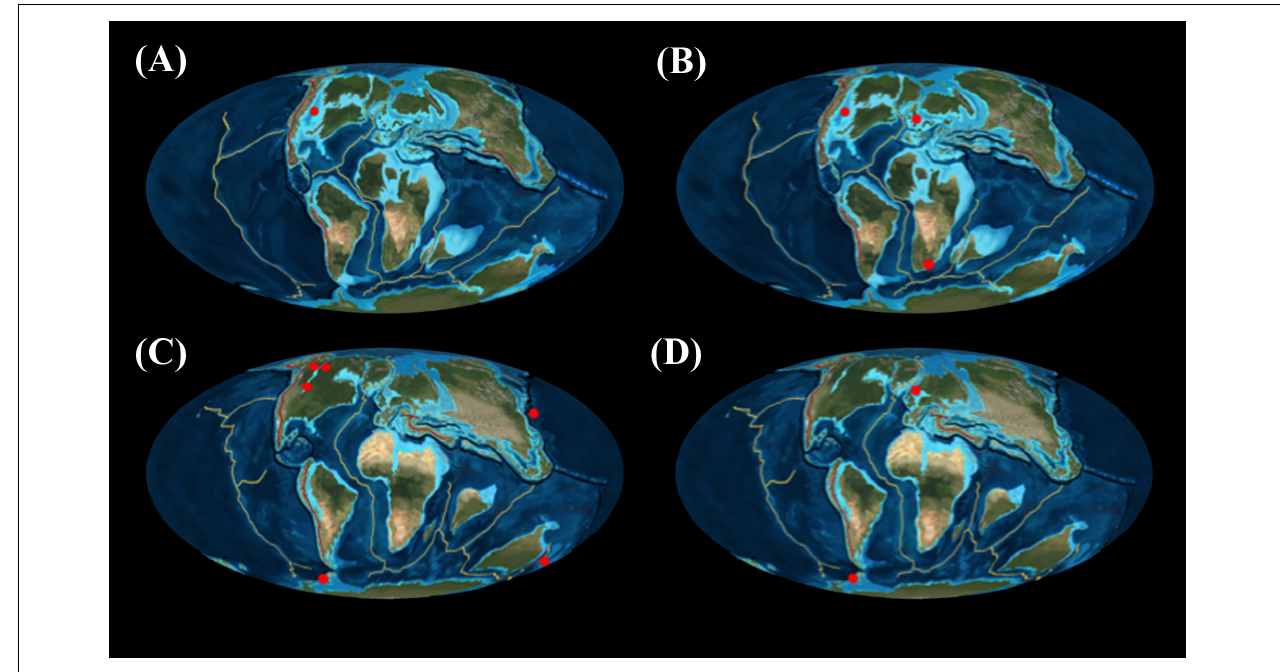
FIGURE 1 | Geographical distribution of tylosaurine species, according to geochronological stages in the Late Cretaceous: (A) Coniacian; (B) Santonian; (C) Campanian; (D) Maastrichtian. Ron Blakey, Colorado Plateau Geosystems.